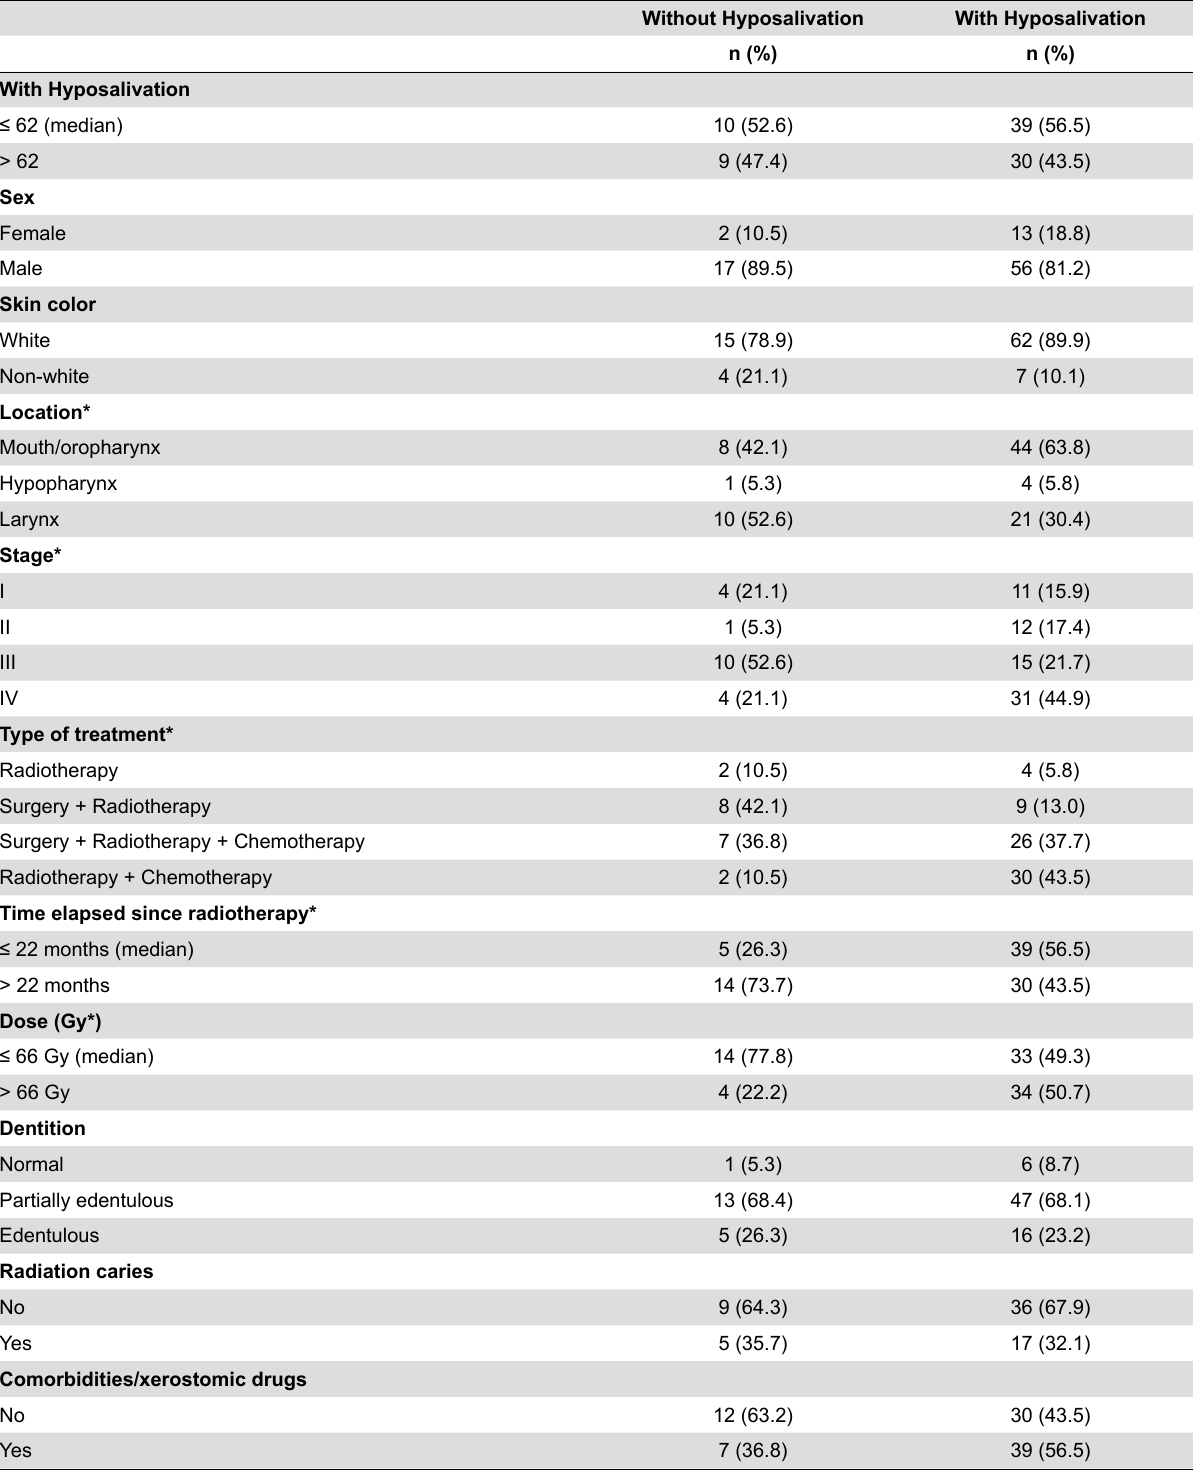
Table 1- Distribution of demographic and clinical variables in groups with and without